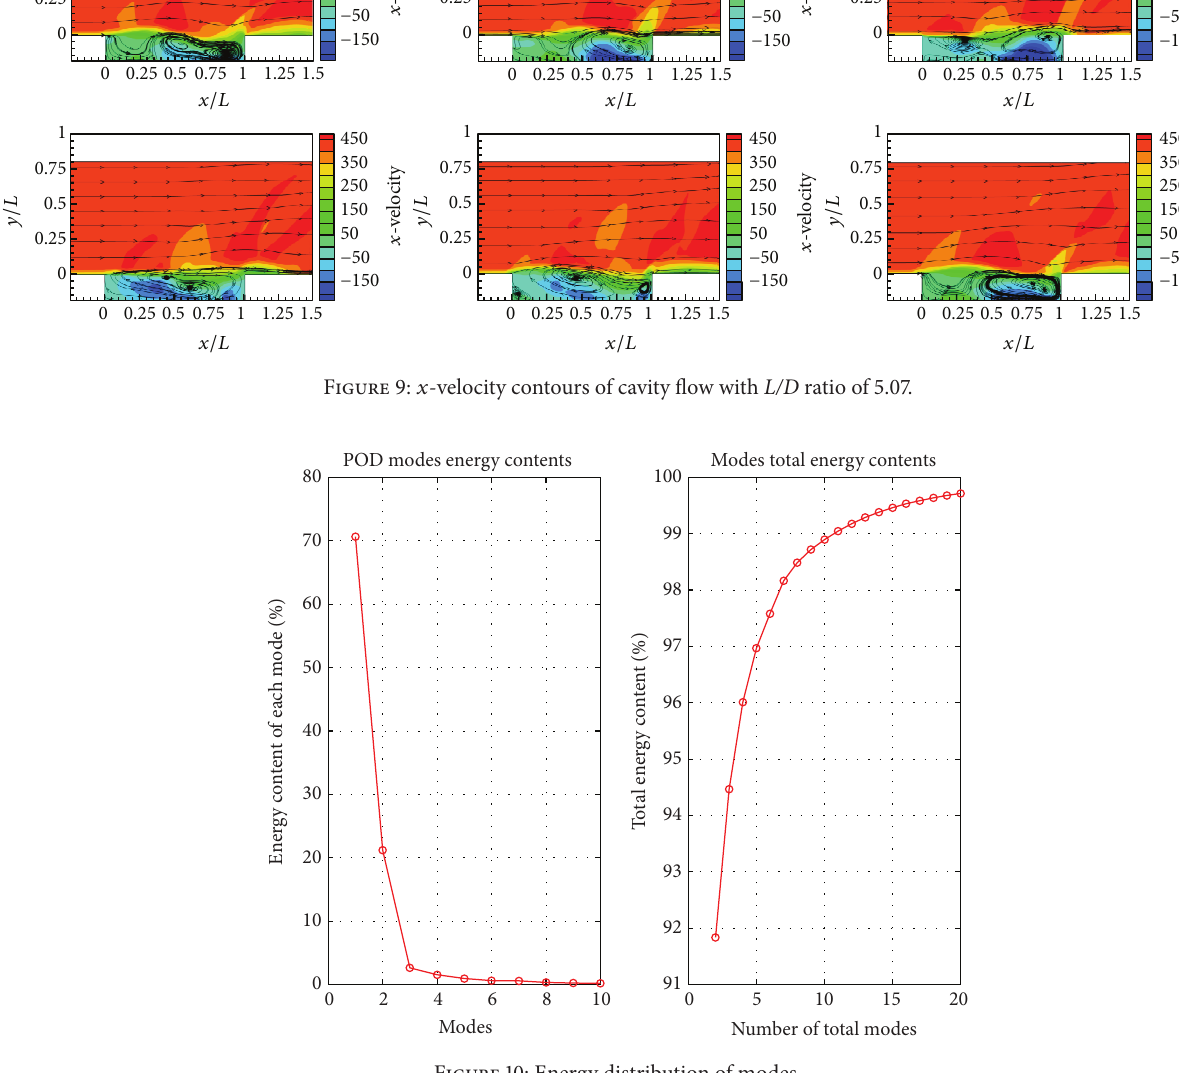
Figure 10: Energy distribution of